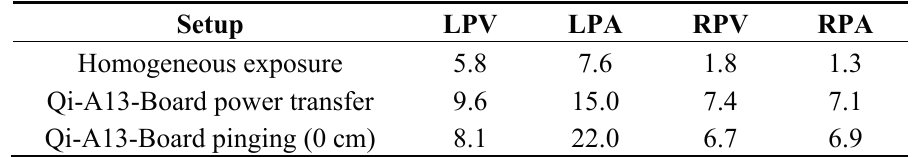
Table 4. Comparison of the factor ( (cid:1873) bipolar leads at the four implantation